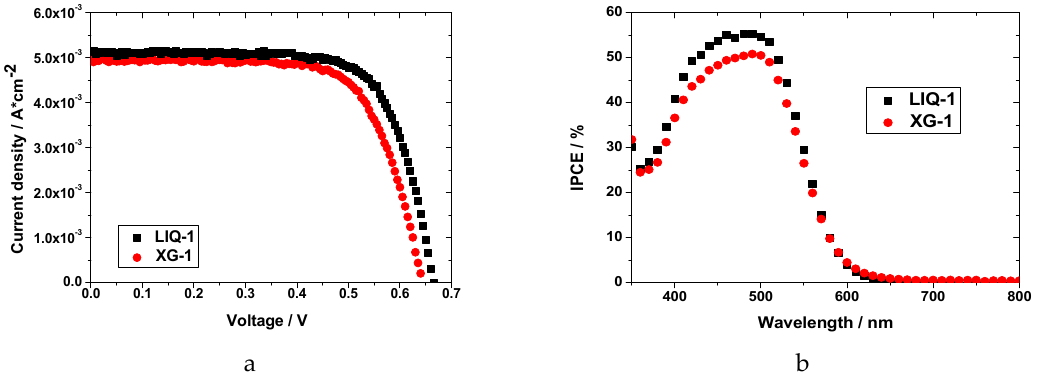
Figure 3. ( a ) J−V curves and ( b ) IPCE spectra for the best LIQ-1 (black squares) and XG-1 (liquid circles) DSSCs measured after ≈1100 h of aging.